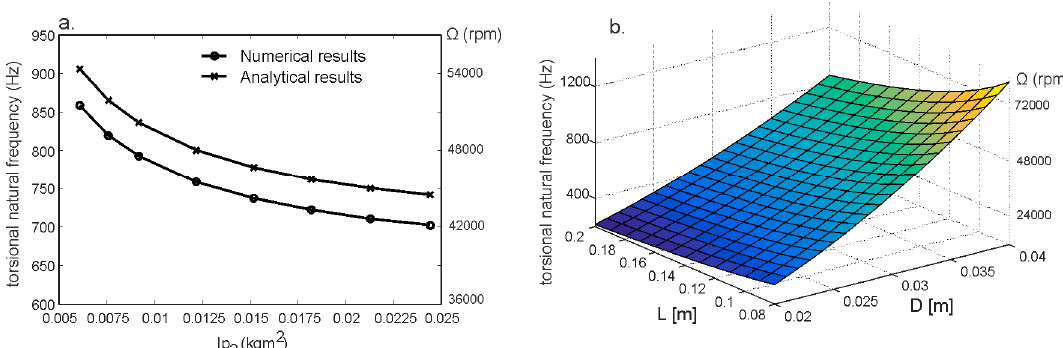
Figure 14. Dependency of the torsional natural frequencies and critical speeds on the: ( a ) different polar mass of inertia I p2 of the load (0.005 kg·m 2 < I p2 < 0.025 kg ·m 2 ) at the constant I p1 of the rotor being I p1 = 0.0048 kg·m 2 (for the IPM rotor: D = 31 mm and L = 80 mm) and ( b ) different lengths and diameters of the